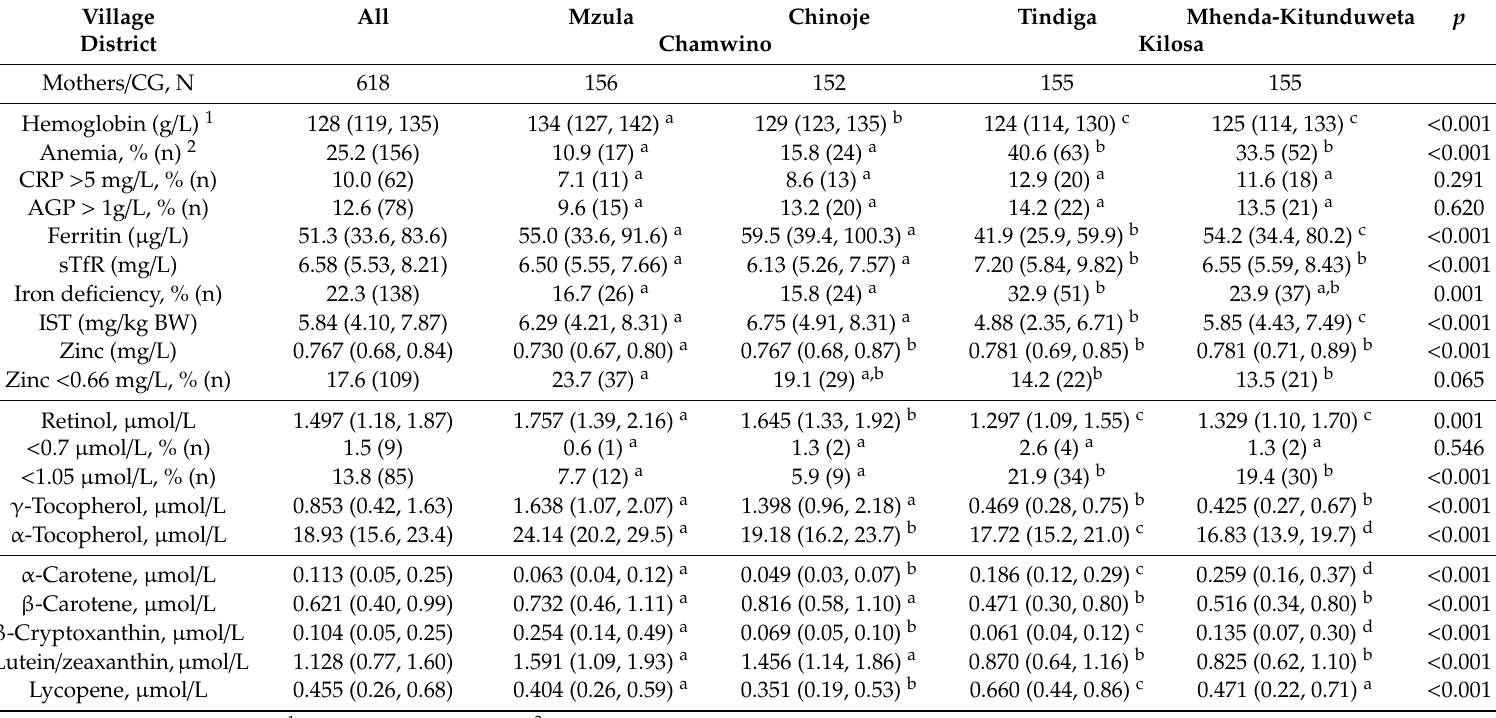
Table A1. Hemoglobin, infection- (CRP, AGP) and iron status markers (ferritin, sTfR), and serum micronutrients in non-pregnant mothers / CG